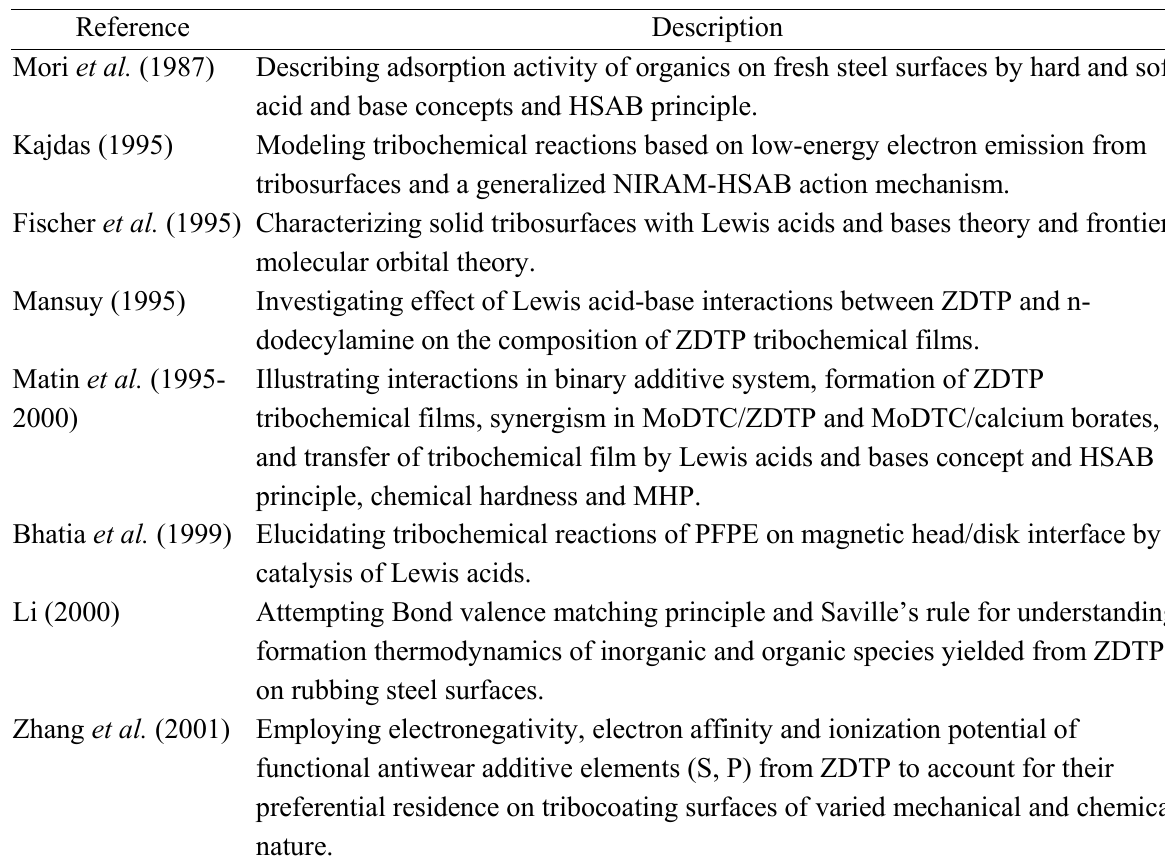
Table 1. Applications of Lewis acid-base concepts and principles in tribochemistry [9,13,14,29-37]. Reference